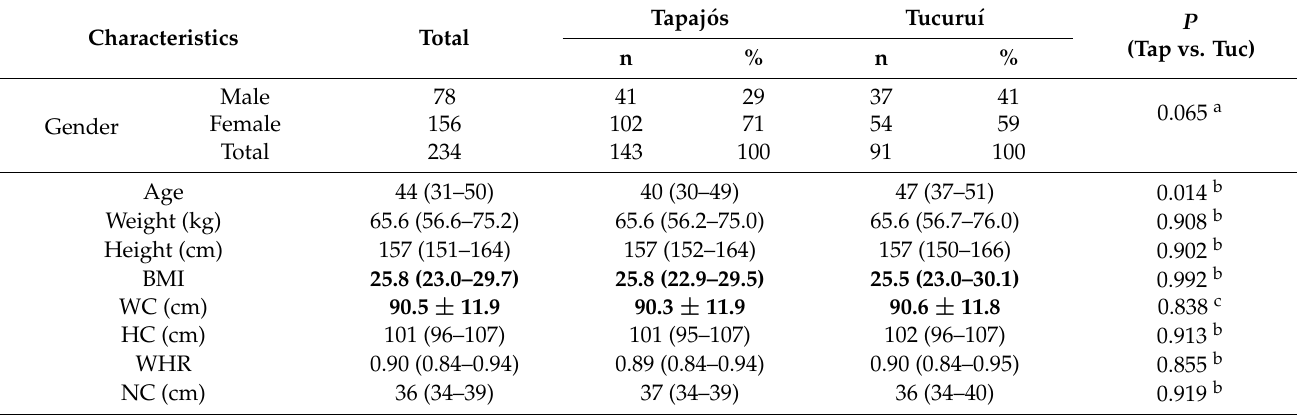
Table 2. Anthropometric characteristics of the participants. Data are presented as the prevalence (%) and median (and interquartile ranges) or mean and standard deviation according to the normality of the data. Values above the limits presented in Table 1 are highlighted in